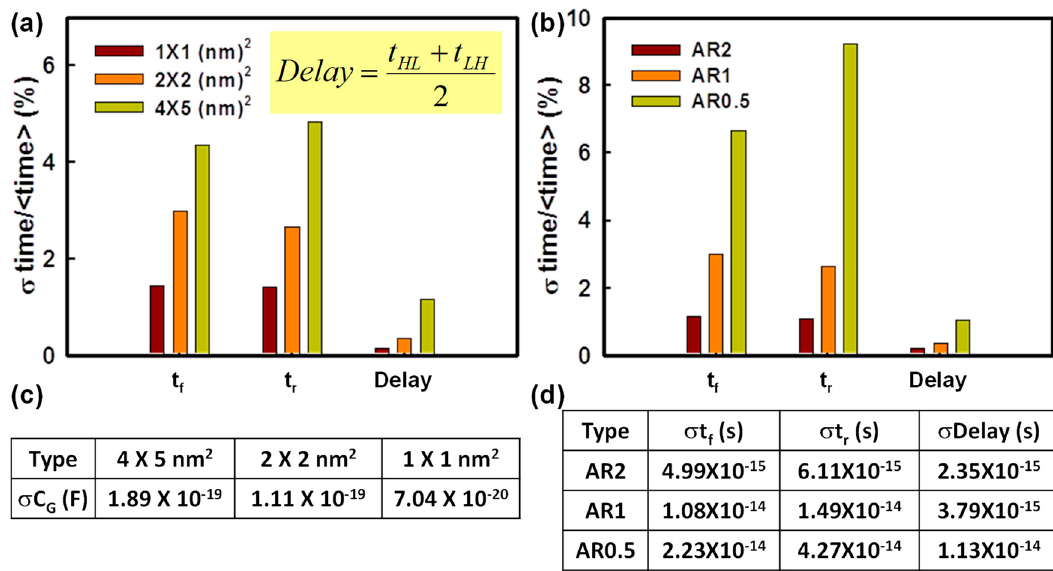
Figure 5. ( a ), ( b ) The coefficient of variance of the timing analysis of GAA NW circuits experiencing WKF with different grain sizes and different ARs, respectively. ( c ) The fluctuation of load gate capacitance with three different grain sizes. ( d ) The associated values of fluctuated timing parameters of different ARs. The bias condition is V D = 0.05 V and V G = 0.6 V.